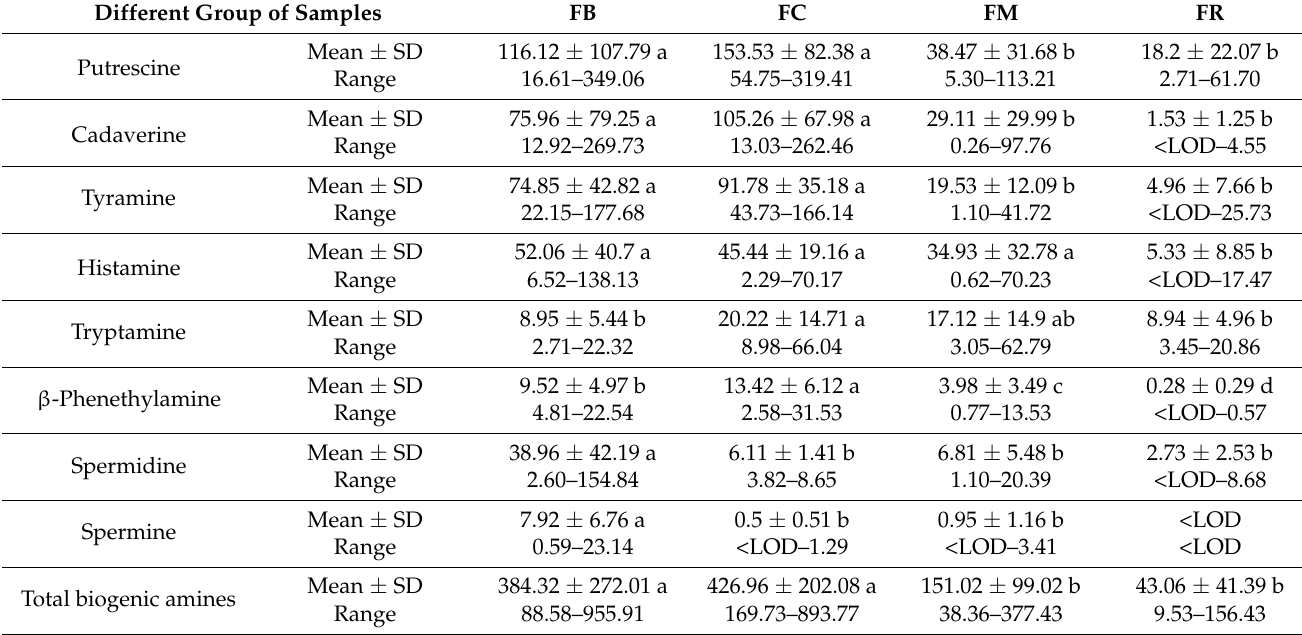
Table 3. The concentrations of biogenic amines in different types of fermented vegetables: FB, fermented bamboo; FC, fermented cabbage; FM, fermented mustard; FR, fermented radish; LOD: limit of detection. Mean ± SD (standard deviation) values in the same row followed by different letters (a, b, c, etc.) are significantly different (Duncan’s test, p < 0.05). Different Group of